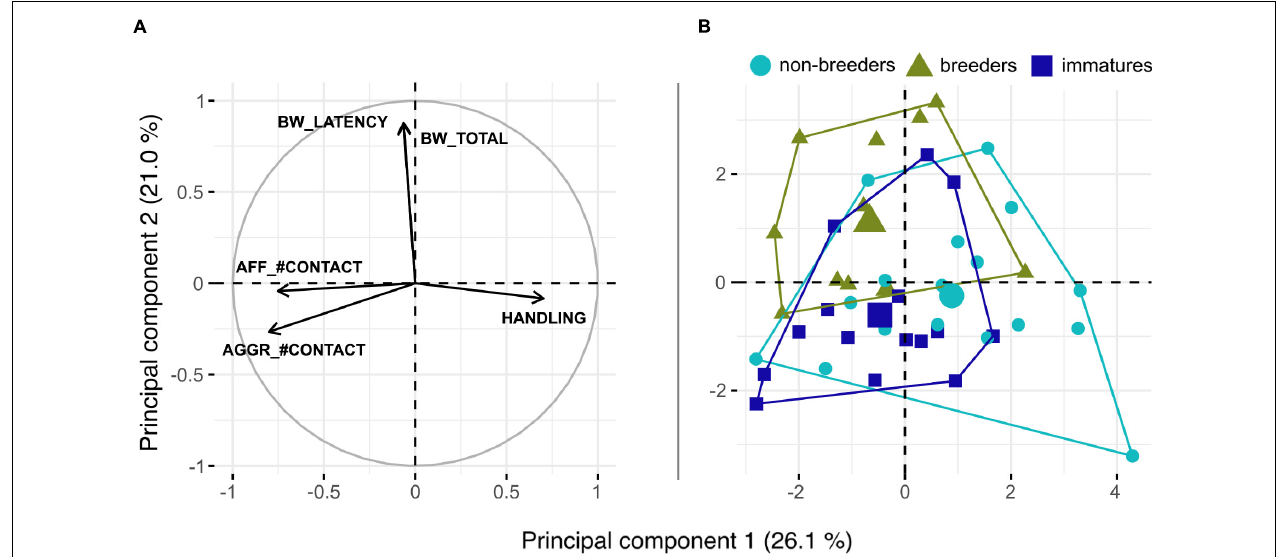
FIGURE 1 | (A) Principal component analysis (PCA) plot showing the five variables that contributed most to the PCA. The arrows for both variables measured during the bubble wrap test, BW_LATENCY and BW_TOTAL, were parallel to each other and almost perpendicular to the variables constituting PC1. (B) PCA plot showing individuals grouped according to their social status. Enlarged symbols mark group